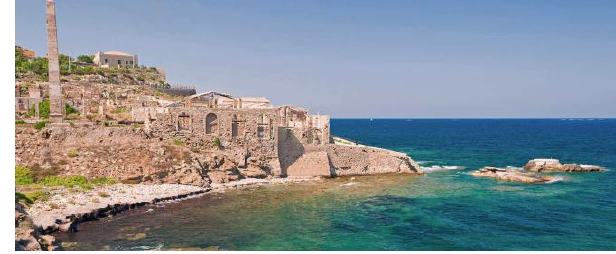
Figure 1. The tonnara of Portopalo.